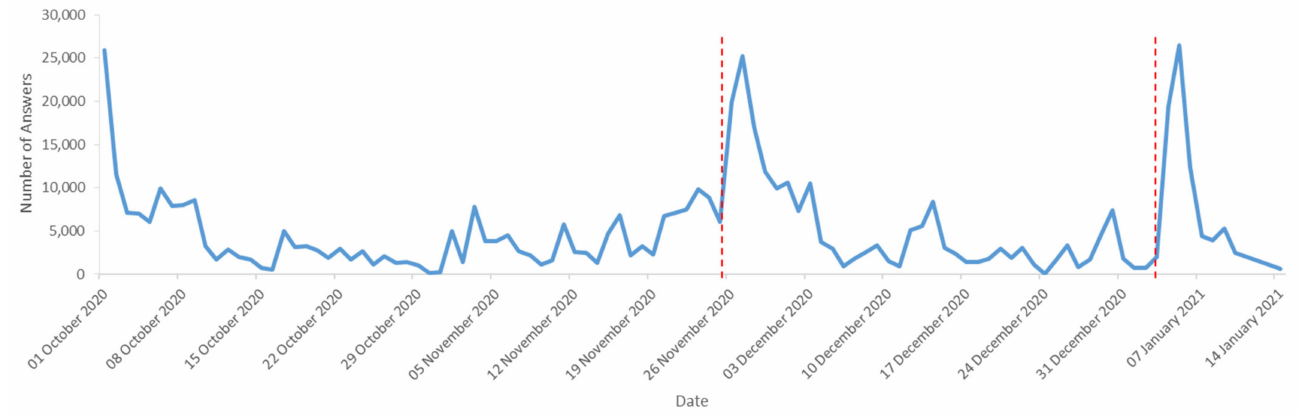
Figure 8. Numbers of answers added over time during the second phase of the